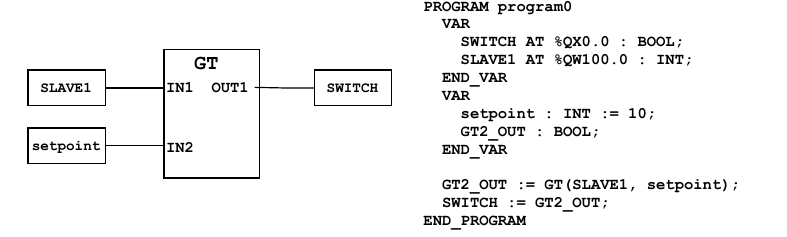
Figure 11. Simple example for a Greater-Than (GT) function block: LL vs. ST